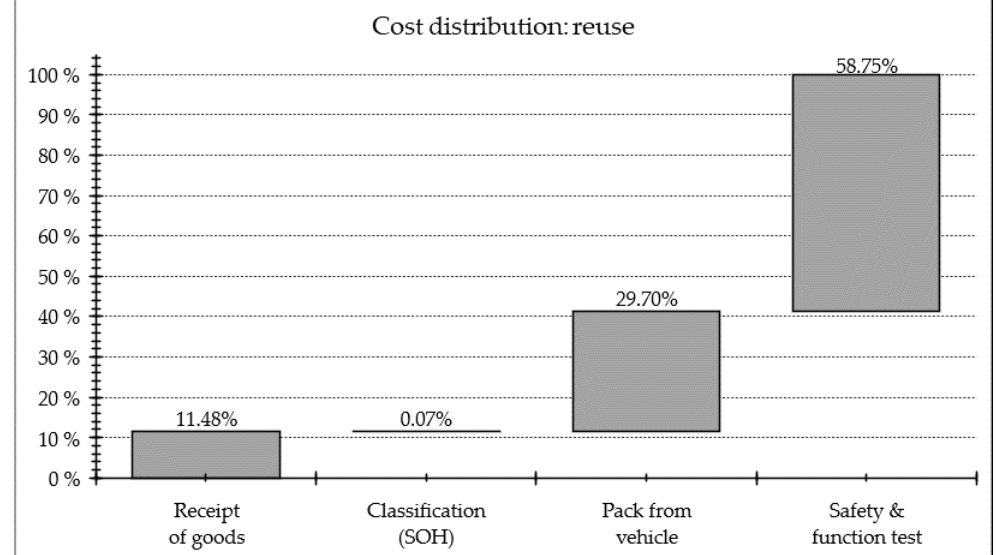
Figure 6. Cost distribution for the reuse scenario under standard cost assumptions.